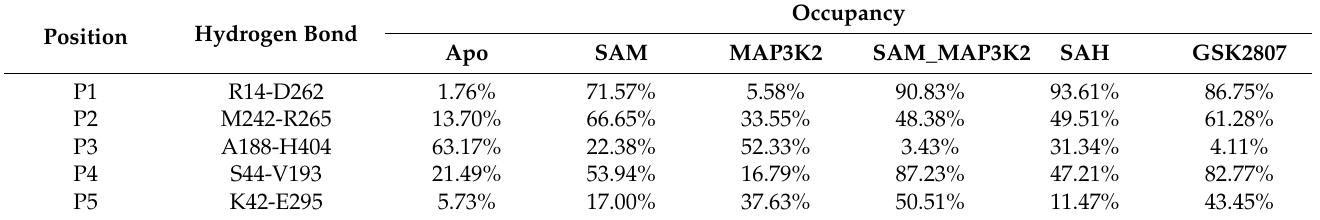
Table 2. Occupancies of hydrogen bonds at the P1–P5 positions during MD simulations.